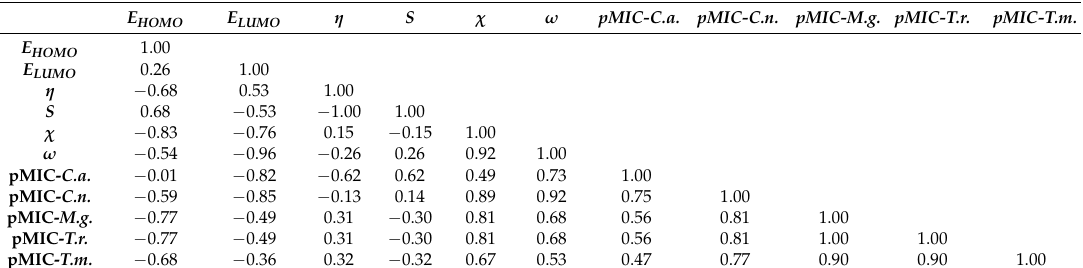
Table 5. Correlation matrix of global reactivity indexes and pMICs against five fungal species for compounds 4a – g .